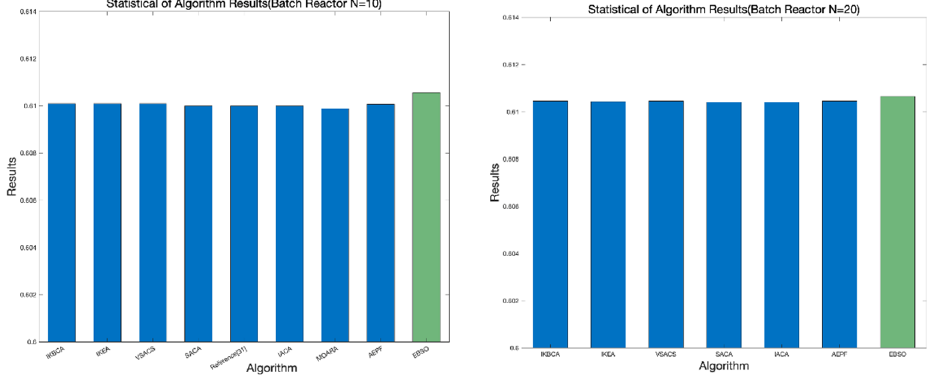
Figure 27. Statistical chart of algorithm results.